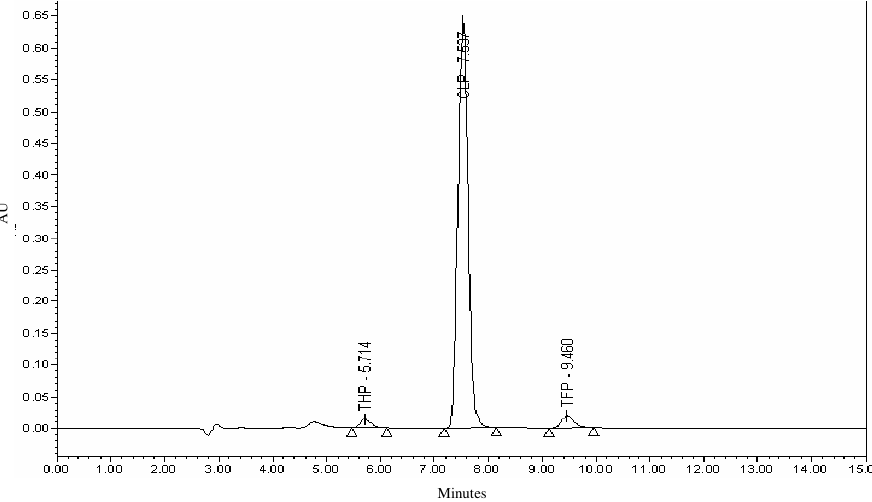
Figure 5. Typical chromatogram for sample preparation containing 10 µ g/mL of THP, 25 µ g/mL of TFP and 125 µ g/mL of CLP chromatographed on INERTSIL-ODS-SP column (250 x 4.6) mm, 5 µ m in isocratic elution using ammonium acetate (1%, w/v) and Methanol in proportion of 85 : 15 v/v used as mobile phase and measured at 215